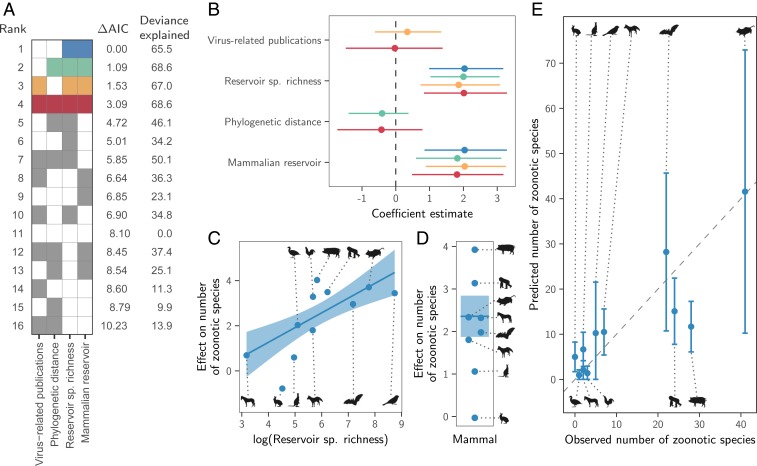
Factors predicting the number of zoonotic virus species across animal orders. (A) Models for all possible variable combinations ranked by AIC. Each row represents a model, while columns represent variables. Filled cells and white cells indicate variable inclusion and absence, respectively. The top four model are color-coded, with colors reused in all other panels to identify the respective models. (B) Coefficient estimates for the top four models; points indicate the maximum likelihood estimate and lines show 95% CIs. All variables were scaled by dividing them by 2 times their SD, meaning coefficients are directly comparable as effect sizes. (C and D) Partial effect plots for variables in the top model. Lines and shading indicate the partial effects and 95% CIs, with points showing partial residuals. (E) Predicted number of zoonotic viruses for each reservoir group when using the top model (blue in A; see SI Appendix, Fig. S5 for other top models).